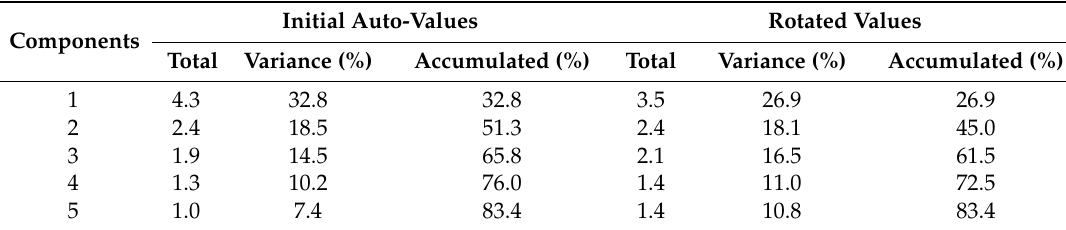
Table 3. Total variance explained after performing a Principal Component Analysis.